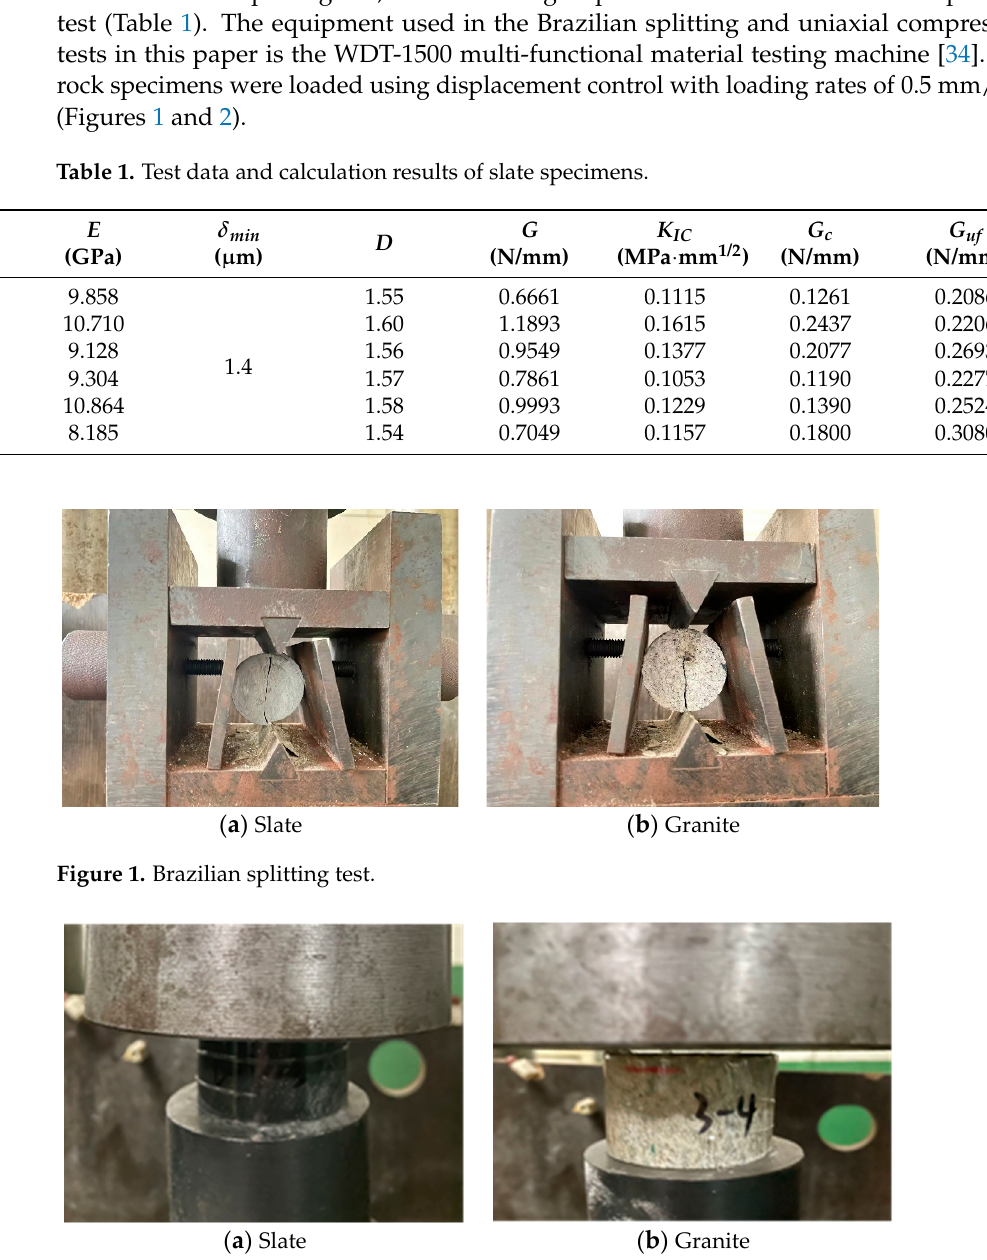
Figure 2. Uniaxial compression test.